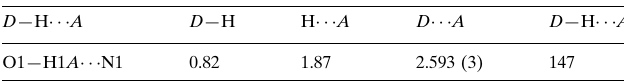
Hydrogen-bond geometry (A˚ , (cid:1)